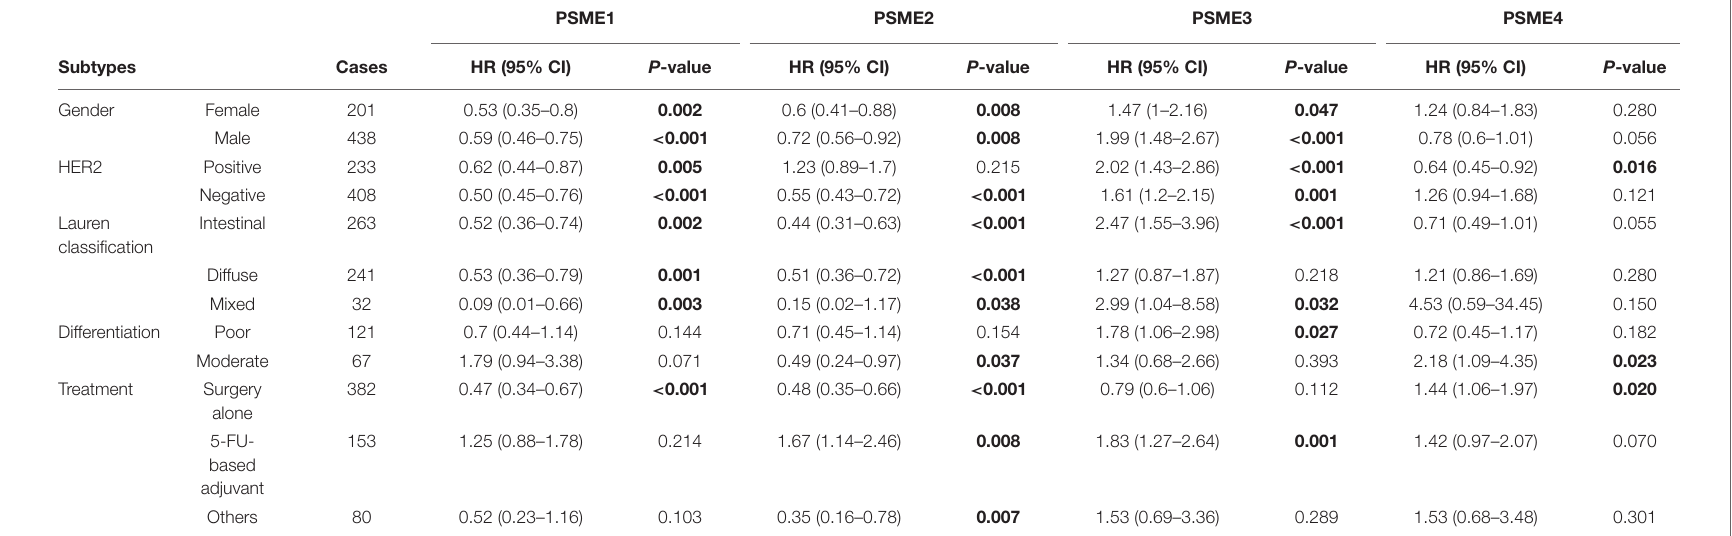
TABLE 2 | The correlation between PSME genes and FPS in different subtypes of GC patients (Kaplan–Meier